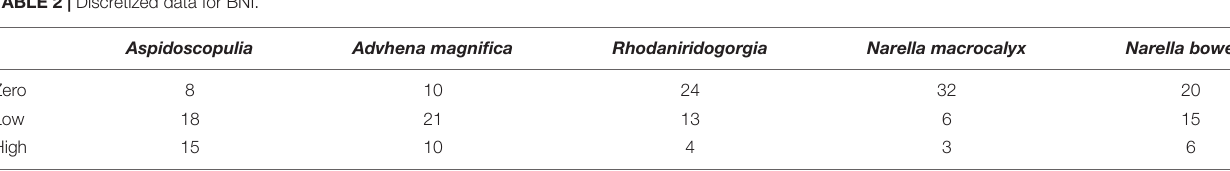
TABLE 2 | Discretized data for